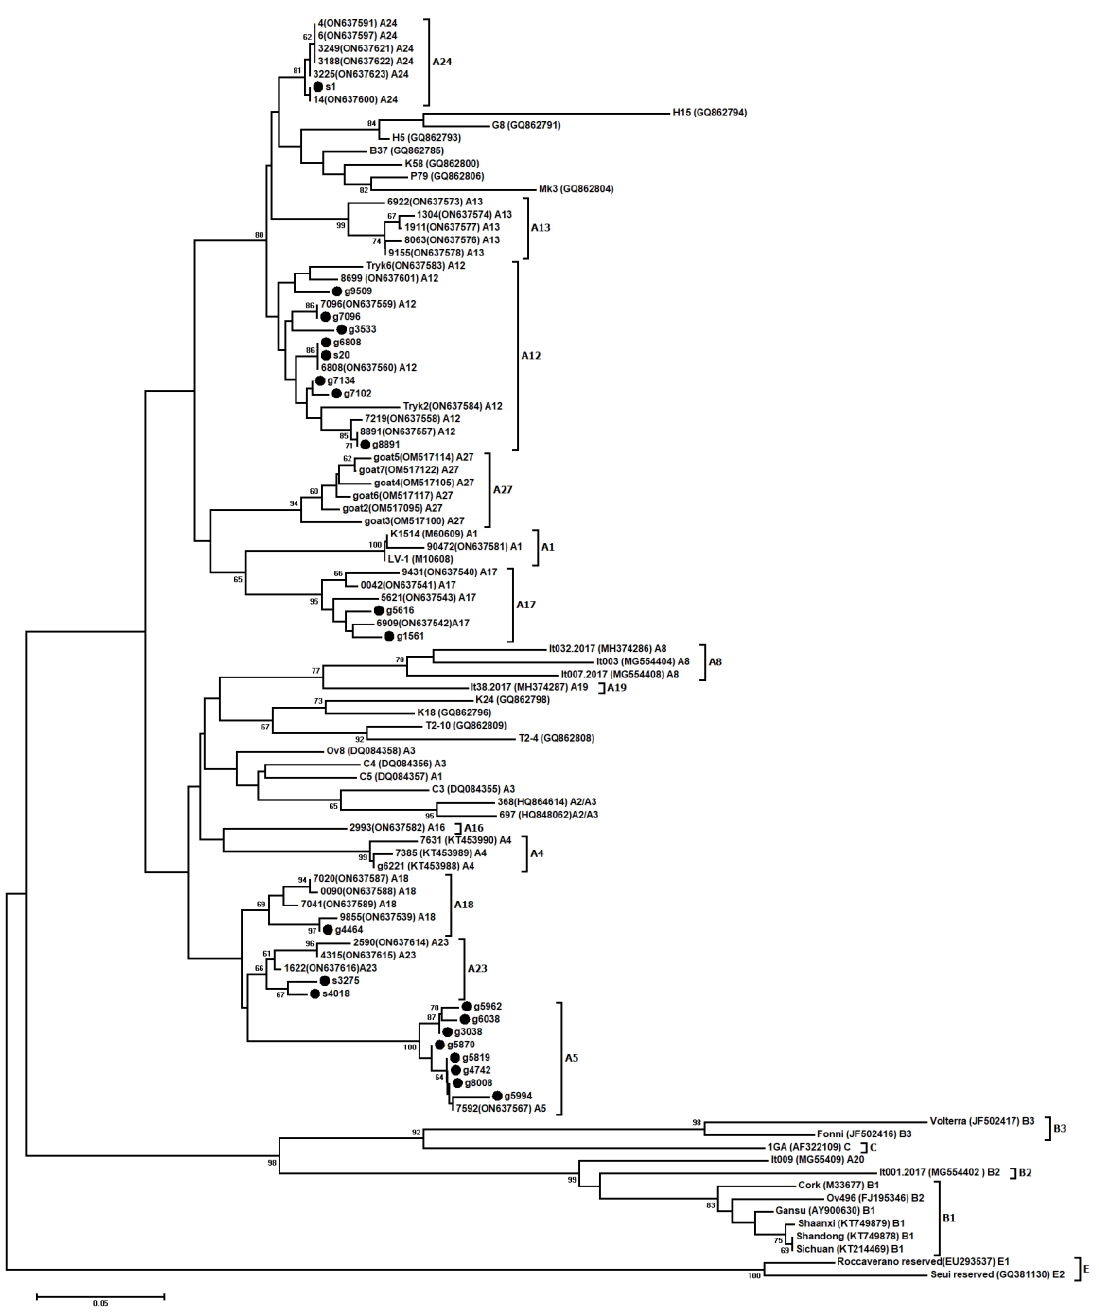
Figure 1. Neighbor-joining phylogenetic tree based on the alignment of the LTR fragment. Sequences from this study are labeled with black circles (s — sheep; g — goat). Reference SRLV strains are shown by name followed by their GenBank accession number and subtype. Numbers at the branches indicate the percentage of bootstrap values obtained from 1000 replicates.